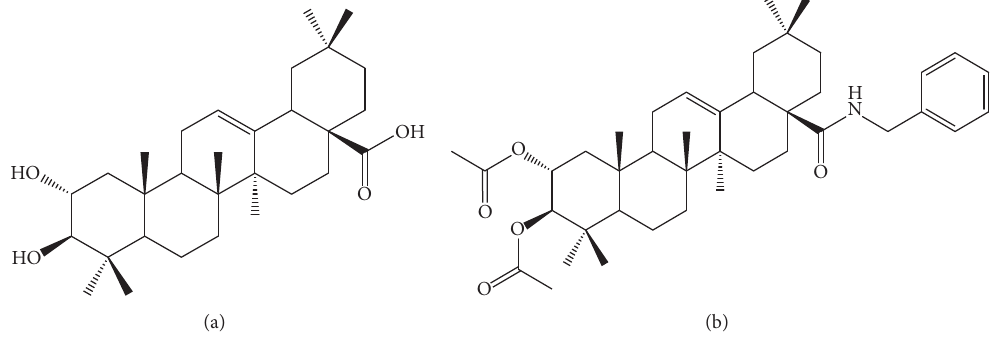
Figure 1: Chemical structure of MA (a) and EM2